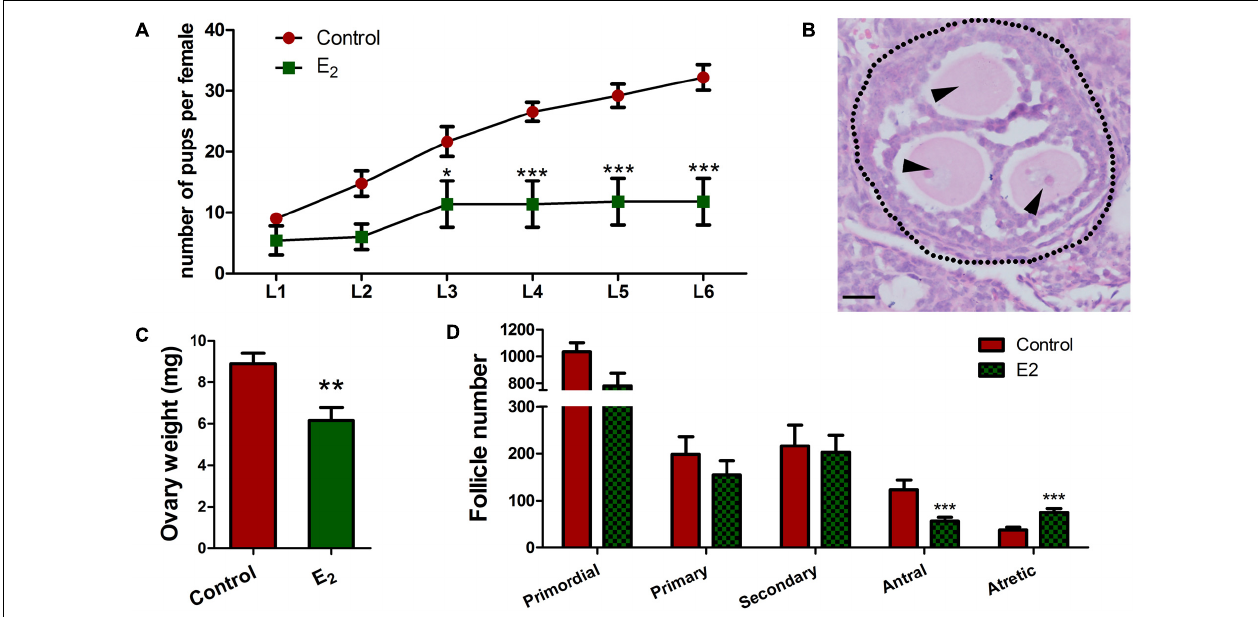
FIGURE 8 | In utero exposure of excessive E 2 compromises female fertility. (A) Female F1 with in utero exposure of E 2 gave birth to fewer pups. (B–D) Prepubertal F1 females were injected with PMSG. (B) An MOF from a mouse in utero -exposed to E 2 . Dotted line: follicle wall, arrowhead: oocyte. Bar: 20 µ m. The effect of in utero exposure of E 2 on ovary weight (C) . Counting analysis for follicle development (D) . Bar: 50 µ m. * p < 0.05, ** p < 0.01, *** p <